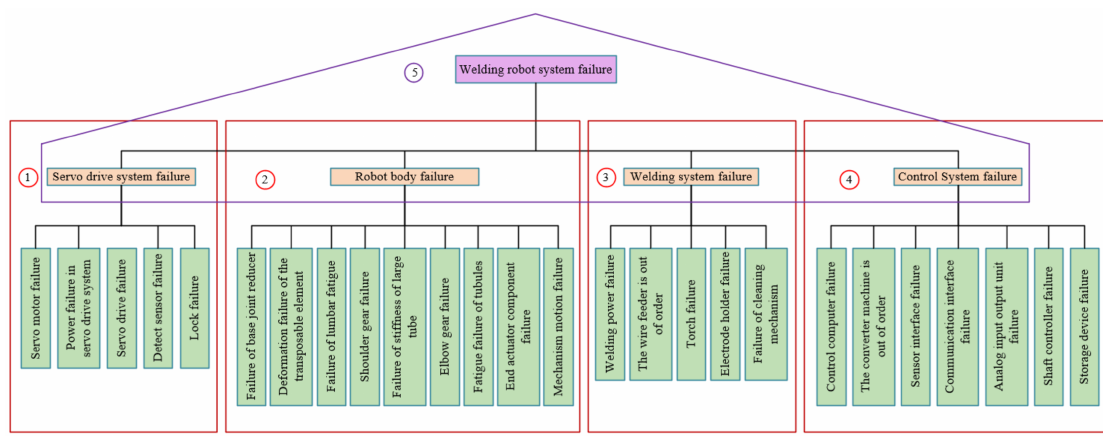
Figure 5. Multi-layer BRB model for diagnosis of welding robot